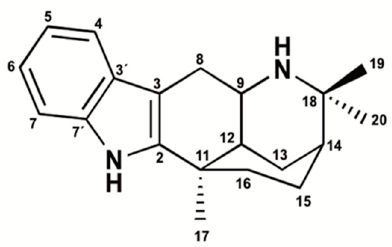
Figure 1. Chemical structure of aristoteline (ARI) .